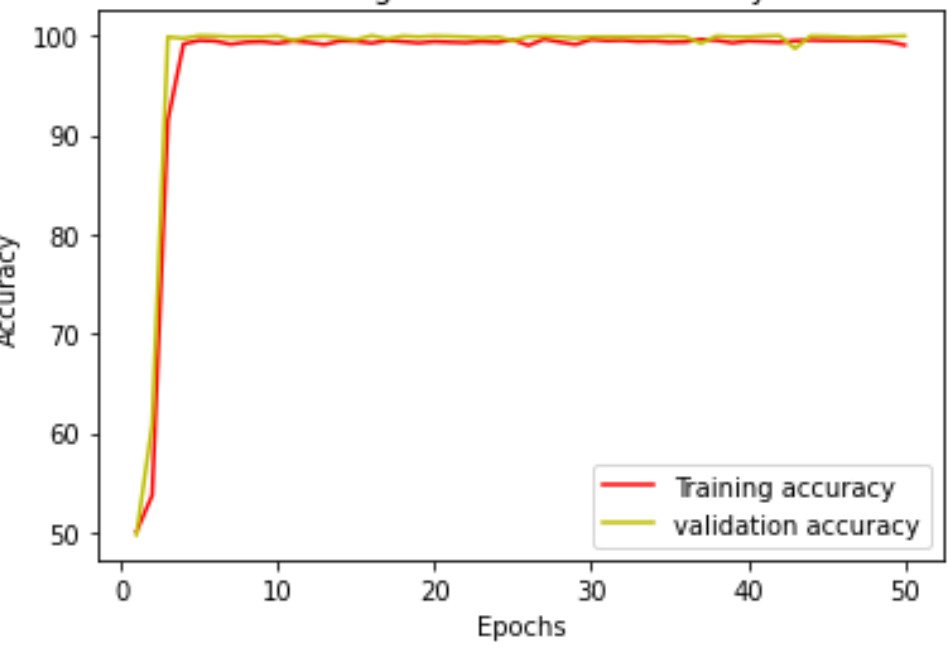
Figure 13. Training and validation accuracy of the CNN